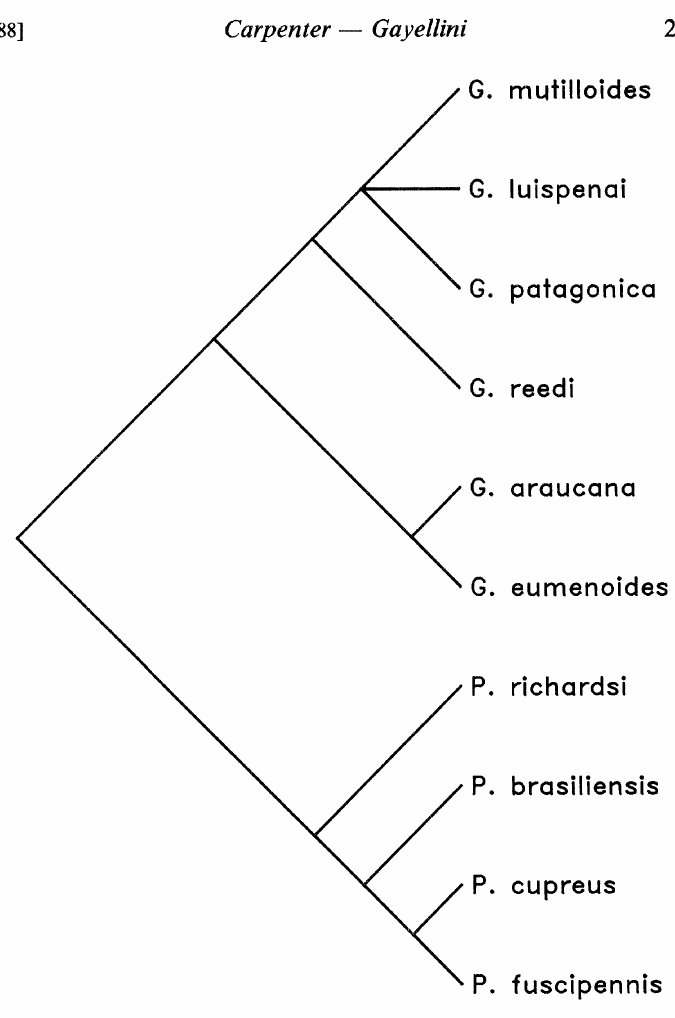
Fig. 2. Cladogram of the species of